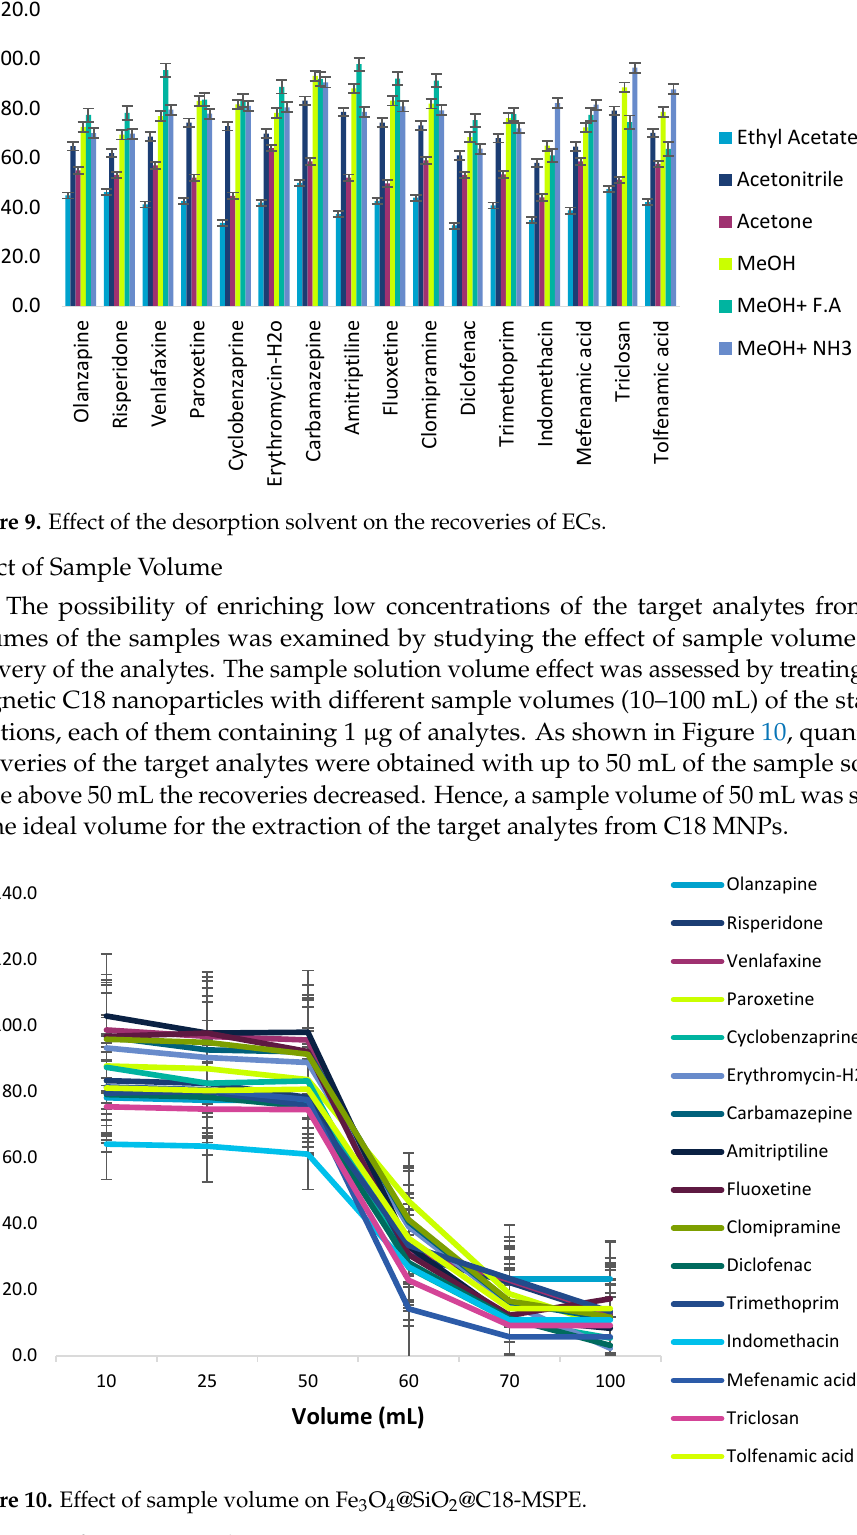
Figure 10. Effect of sample volume on Fe 3 O 4 @SiO 2 @C18-MSPE.